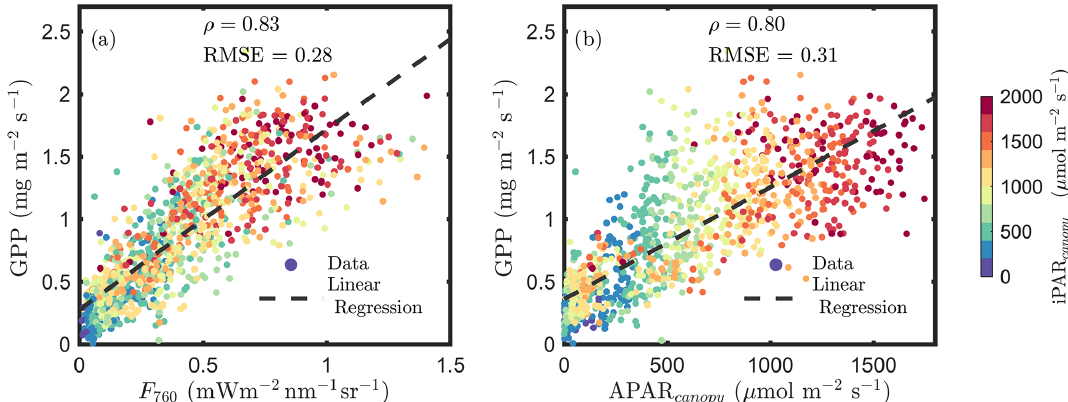
Figure 1. Relationships between far-red SIF ( F 760 ) and GPP and between APAR canopy and GPP of a corn canopy in the 2017 growing season, with a 30min temporal resolution during daylight hours. F 760 and APAR canopy were retrieved from FLoX canopy measurements. GPP was obtained from the site’s flux tower measurements.